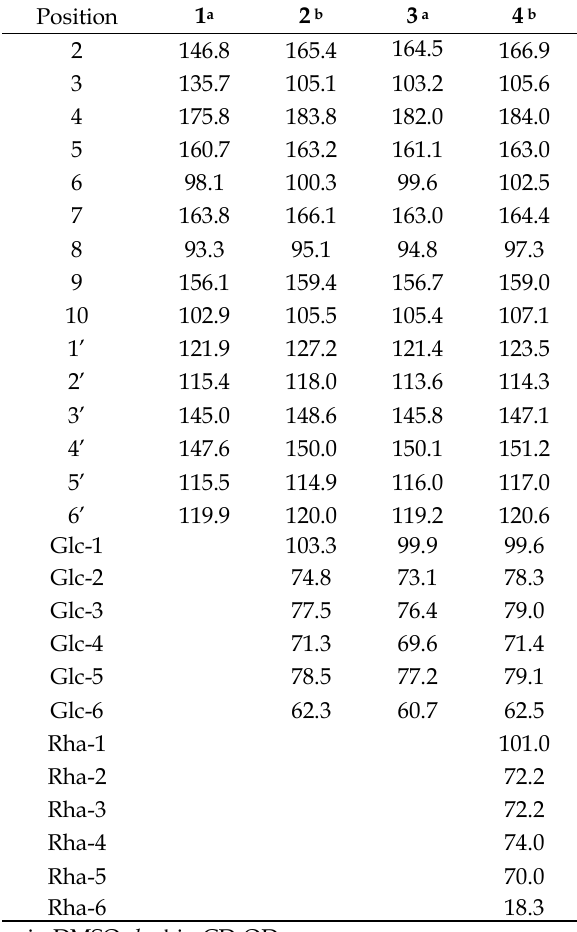
Table 2. 13 C NMR spectroscopic data of compound 1 - 4